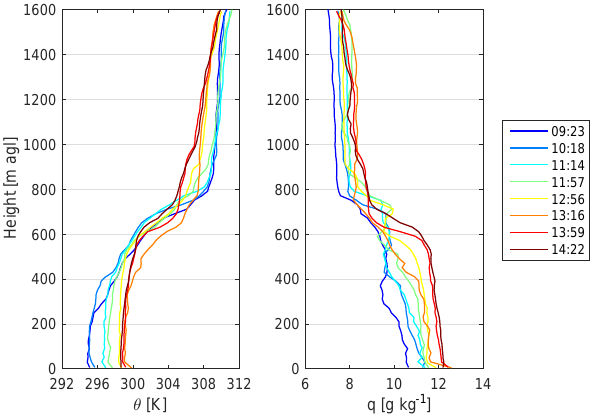
Figure 7. Profiles of potential temperature θ and specific humidity q measured by SUMO on 21 June 2011.